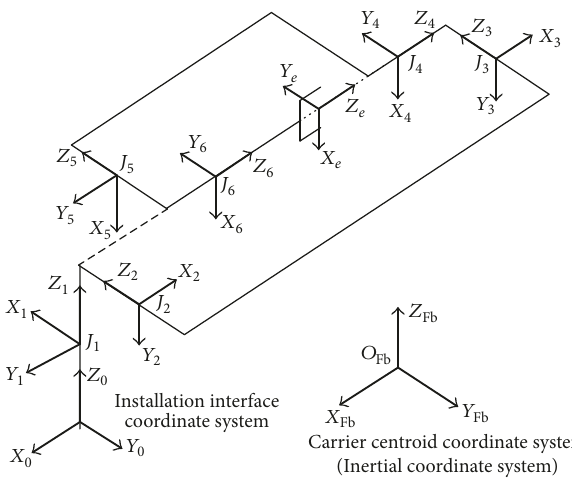
Figure 3: Linkage coordinate frames for a 6-DOF